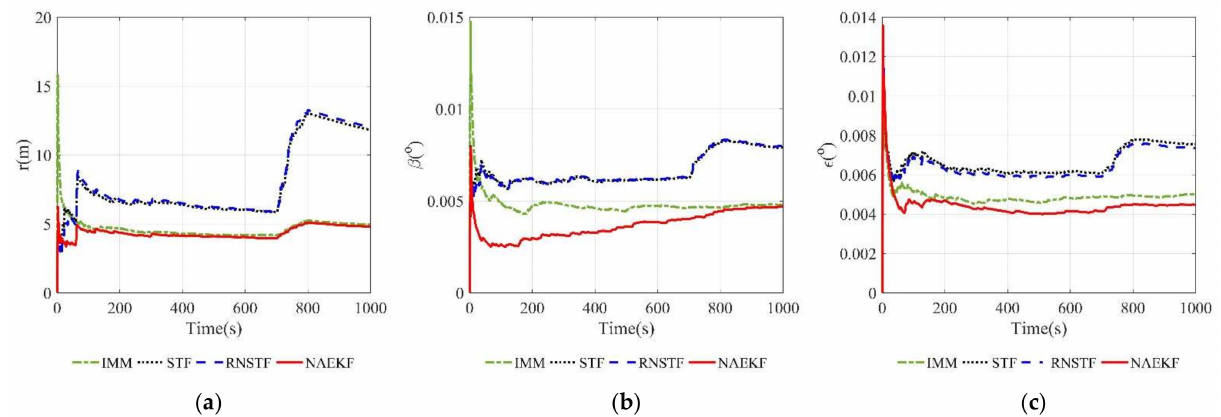
Figure 20. σ -Boundary of position estimation errors. ( a ) σ -Boundary of the range; ( b ) σ -Boundary of the azimuth angle; ( c ) σ -Boundary of the elevation